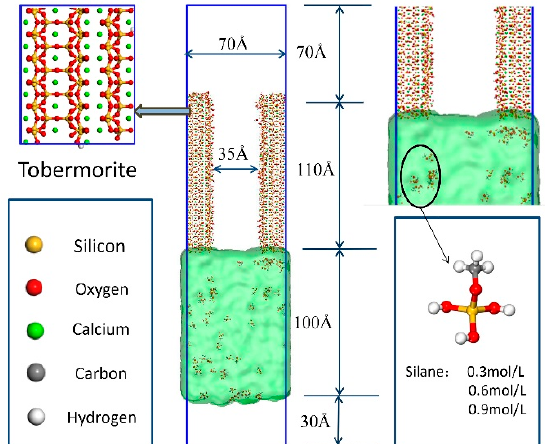
Figure 1. Initial model structure: the red and yellow sticks represent the silicate chains; the green balls are calcium atoms. The green transparent film underneath represents a water film. Silixolecular structure: the gray balls are carbon ions, the yellow balls are silicon ions, the red balls are oxygen ions, and the white balls are hydrogen atoms.